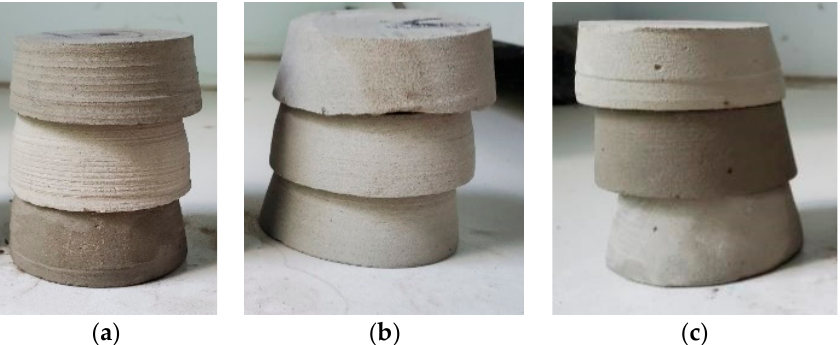
Figure 19. Round table samples of permeability coefficient tests. ( a ) HPCG. ( b ) RPCG. (c) MKCG.